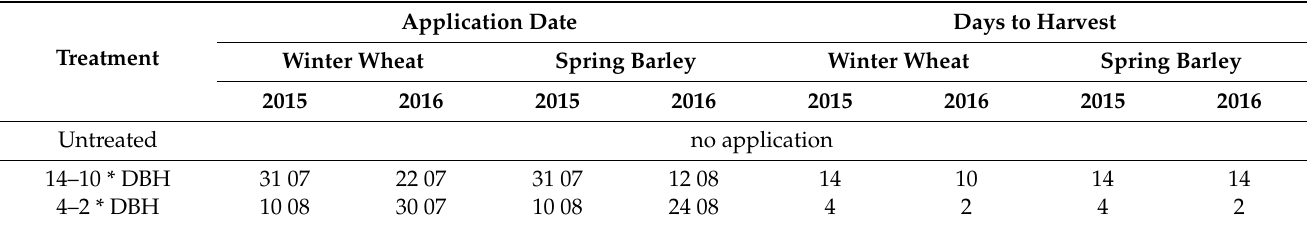
Table 5. Glyphosate application at pre-harvest in winter wheat and spring barley, in 2015 and